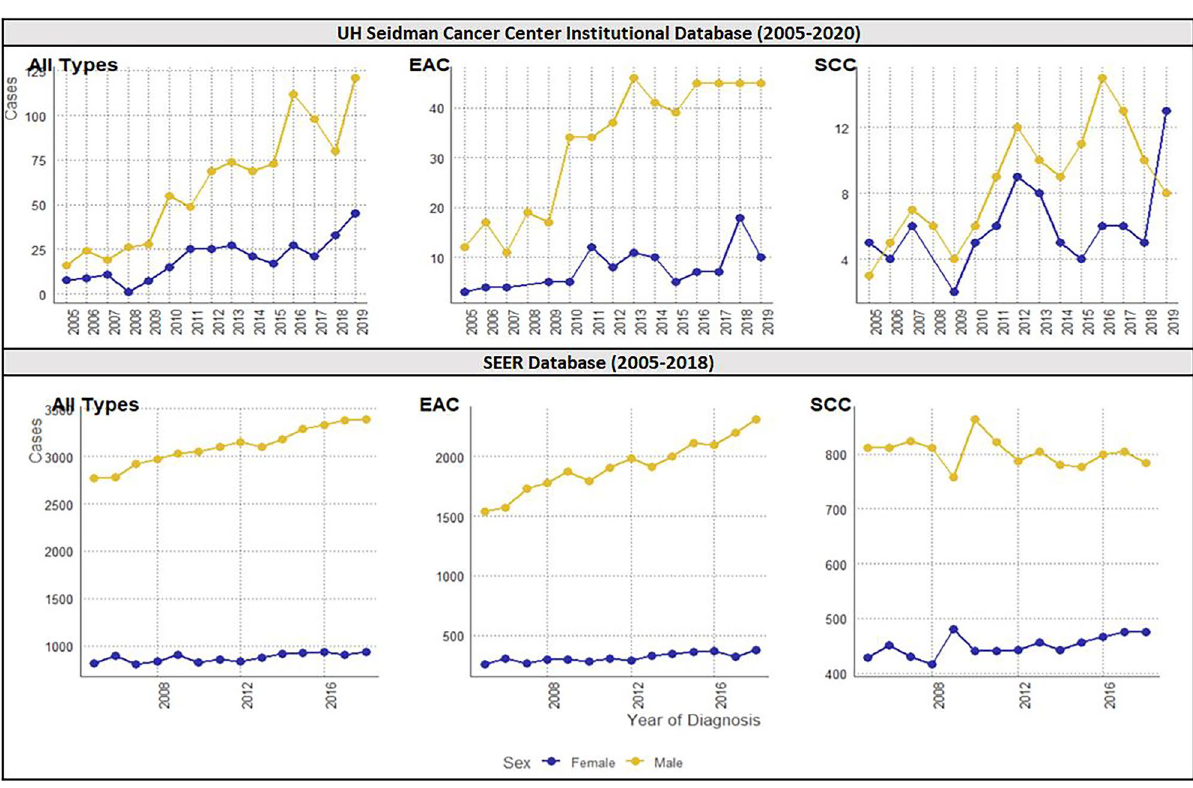
Figure 2. Plots of cases by year from UH Seidman Cancer Center (2005–2020) and SEER (2005–2018) for all types of esophageal cancer, esophageal adenocarcinoma (EAC) and squamous cell carcinoma (SCC). All types of esophageal cancer cases are increasing in the